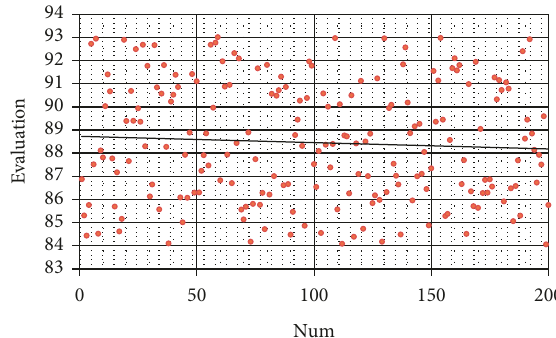
Figure 11: Evaluation of intelligent control effect of automated intelligent control